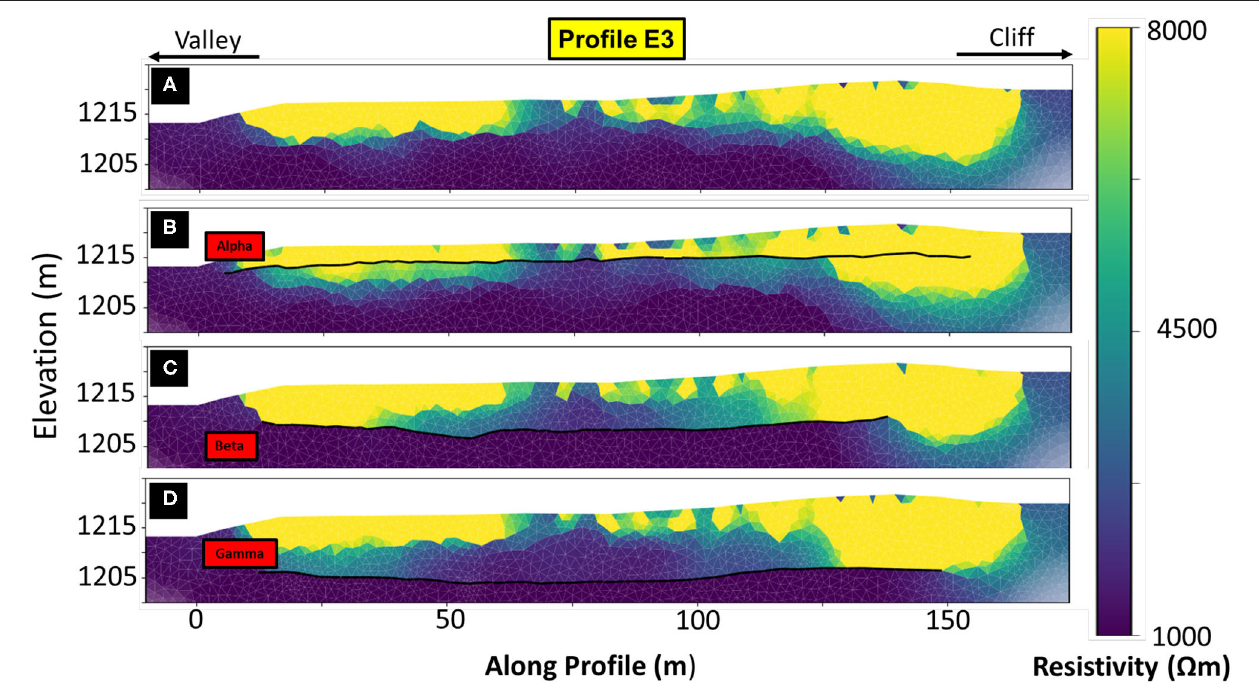
FIGURE 5 | ERT inversion results for profile E3 using smoothness regularization. (A) No additional a-priory information, smoothness applied everywhere. (B) No smoothing across interface Alpha . (C) No smoothing across interface Beta . (D) No smoothing across interface Gamma .